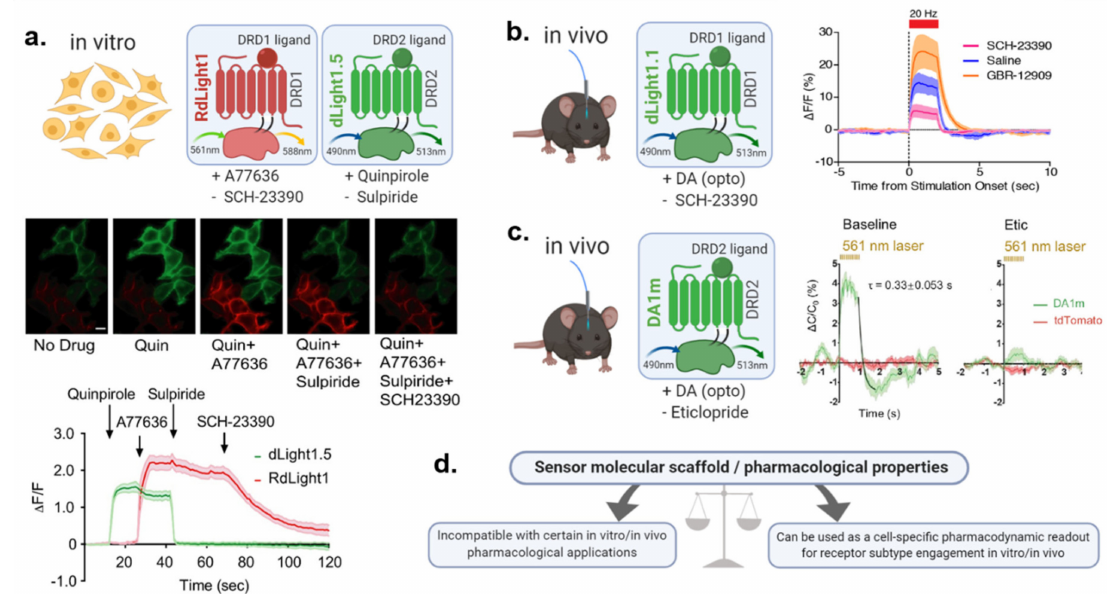
Figure 6. Molecular sca ff old as a double-edged sword for pharmacology and drug discovery: ( a ) In vitro assays: [Top]: multiplex imaging of drug e ffi cacy at distinct dopamine (DA) receptor subtypes in HEK293 cells expressing either RdLight1 ( = DRD1 sca ff old) or dLight1.5 ( = DRD2 sca ff old) in the same culture dish. [Middle]: representative images of HEK293 cells and their average fluorescent responses (dFF)toindividualdrugs. Scalebars, 10 µ m. [Bottom]: Simultaneouslymeasuredfluorescenceresponses of both sensors during bath application of DRD1 drugs: A77636: 100 nM, SCH23390: 10 µ M and DRD2 drugs: Quinpirole (Quin): 10 µ M, Sulpiride: 400 nM [59]. ( b , c ) In vivo assays: photometry imaging of drug e ffi cacy at DRD1 ( b ) and DRD2 ( c ) receptors in mice expressing dLight1.1 ( = DRD1 sca ff old) or GRAB-DA1m ( = DRD2 sca ff old) in the NAc or striatum following optogenetic (opto) stimulation